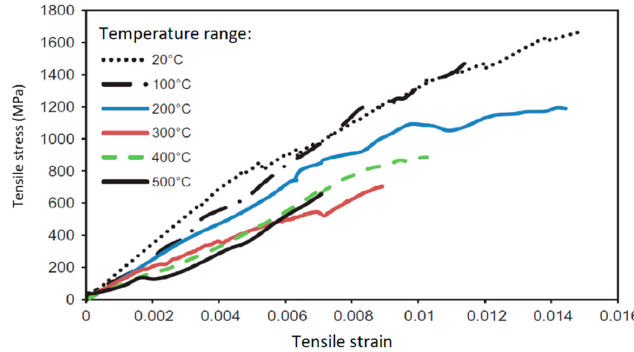
Figure 11. Variation of tensile strength and elastic modulus of CRFP strips with temperature. ( a ) Tensile strength; ( b ) Elastic modulus.